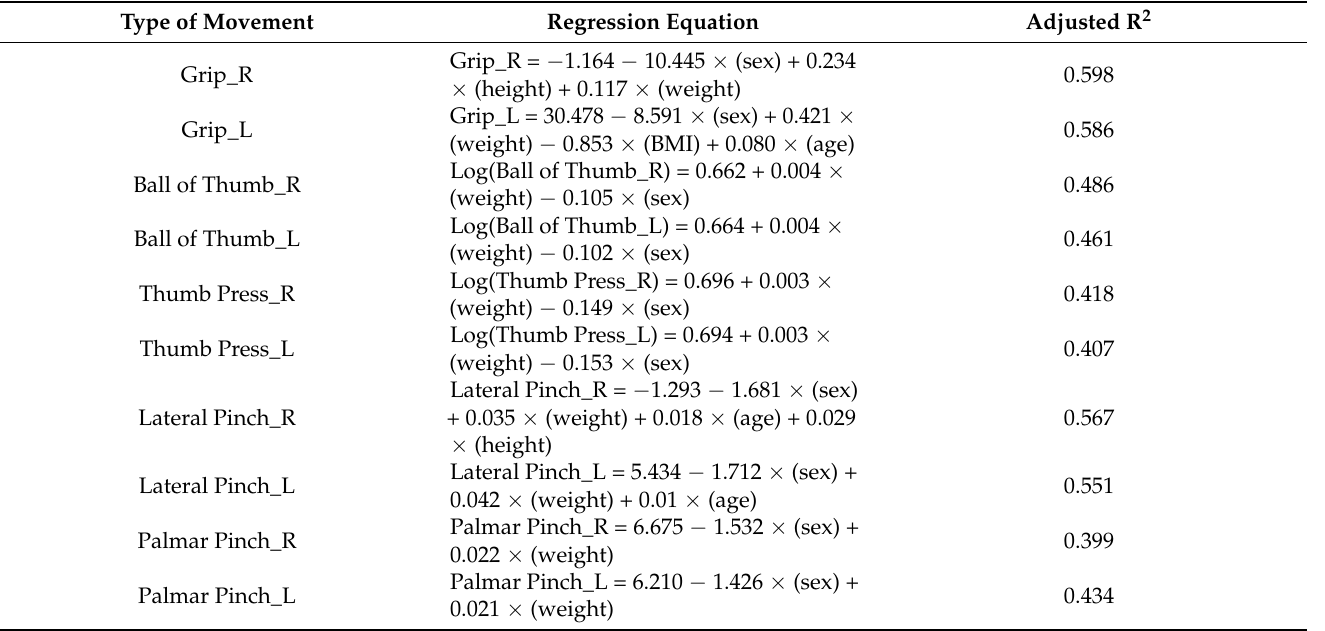
Table 5. Prediction models for different types of hand strength using demographic information.